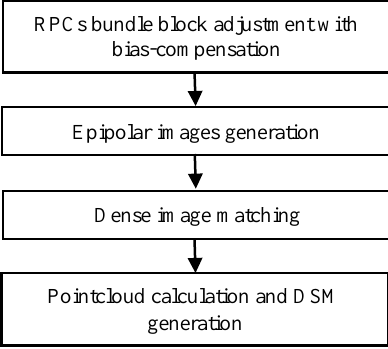
Figure 1. Overview of the workflow